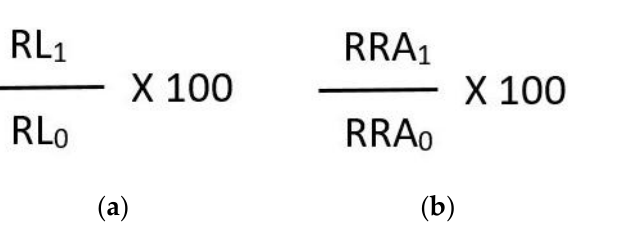
Figure 3. The formulae used to calculate relative measurements (%) of the radiographic length ( a ) and root area ( b ).